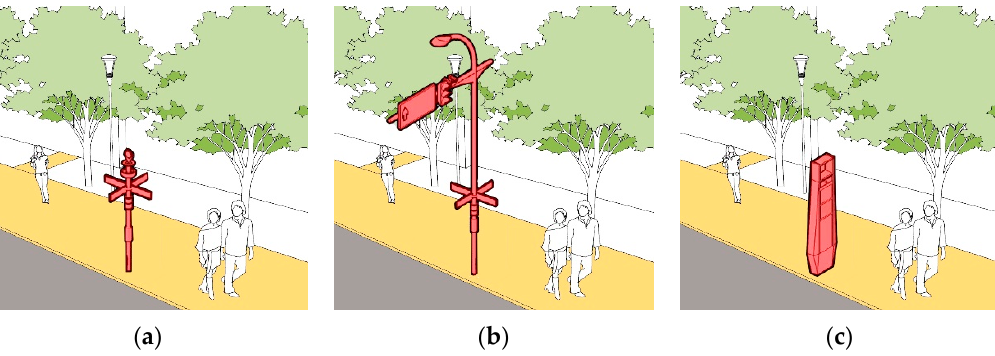
Figure 17. Schematic Design of Multi Pole Integration: ( a ) Street Lamp Pole as the Basis of Integration; ( b ) Traffic Pole as the Basis of Integration; ( c ) Information Board Integration.